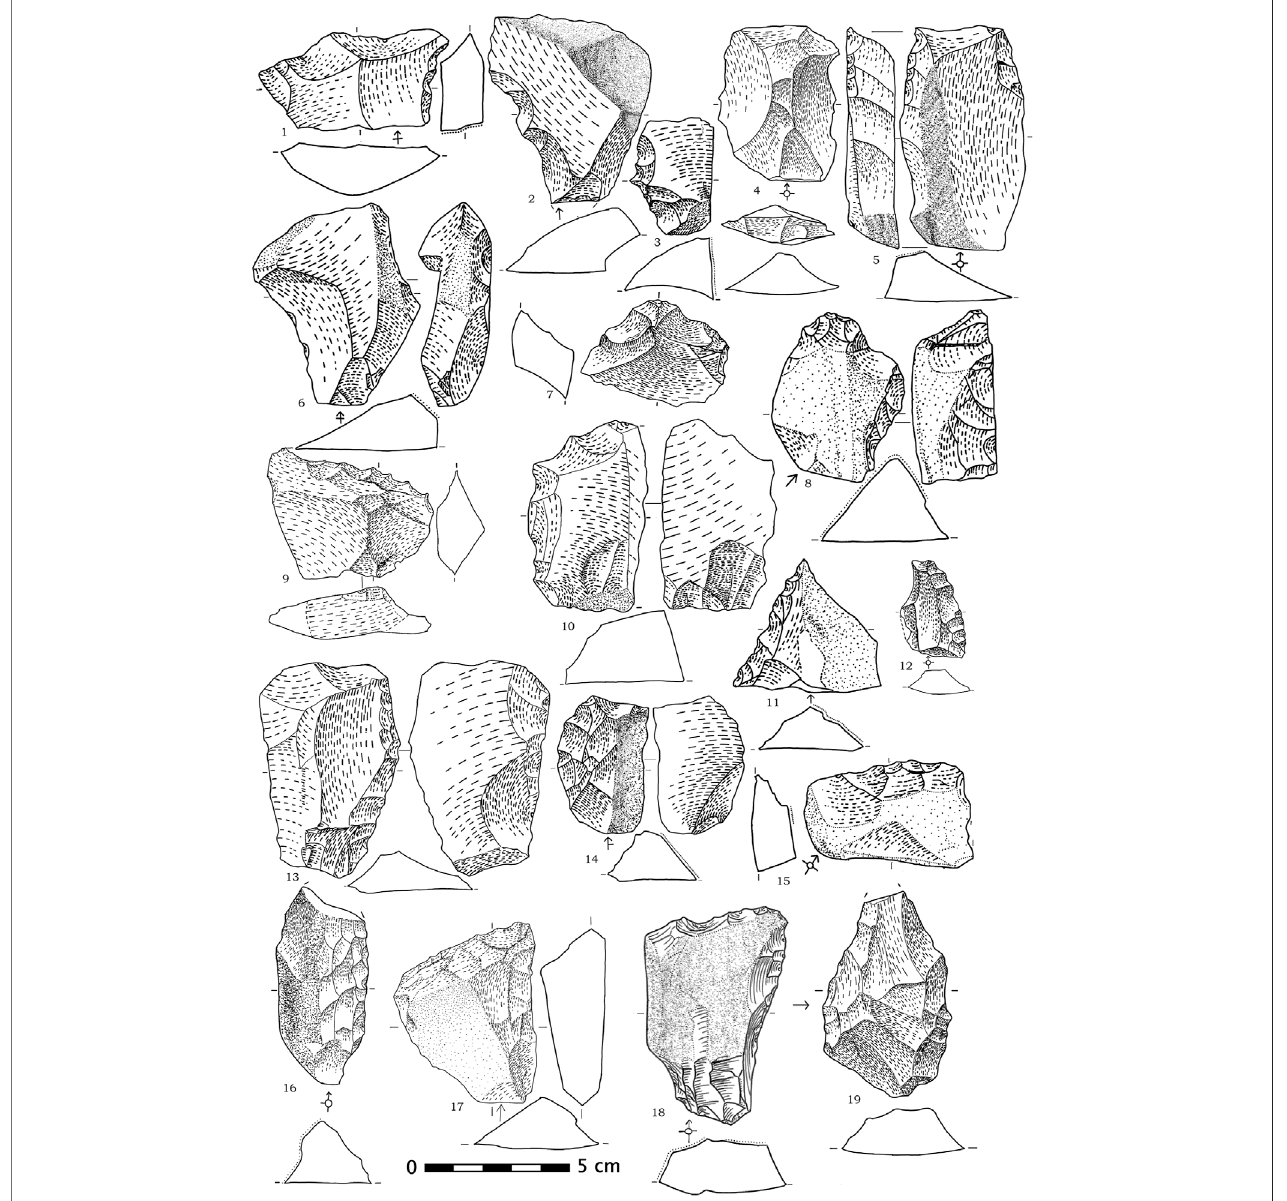
FIGURE6| Flaketools:doublenotches(1,2);bec(3); fl akewithLevalloismorphology(4);typicalandcorticalbackknives(5,6);end-scrapers(7,8);denticulates(9, 10, 11); convex scrapers (12, 13, 14), straightscraper (15),straight scraper with stepped retouch (16) and convergent scrapers (17, 18and 19). Chert (18)and quartzite (1-17 and